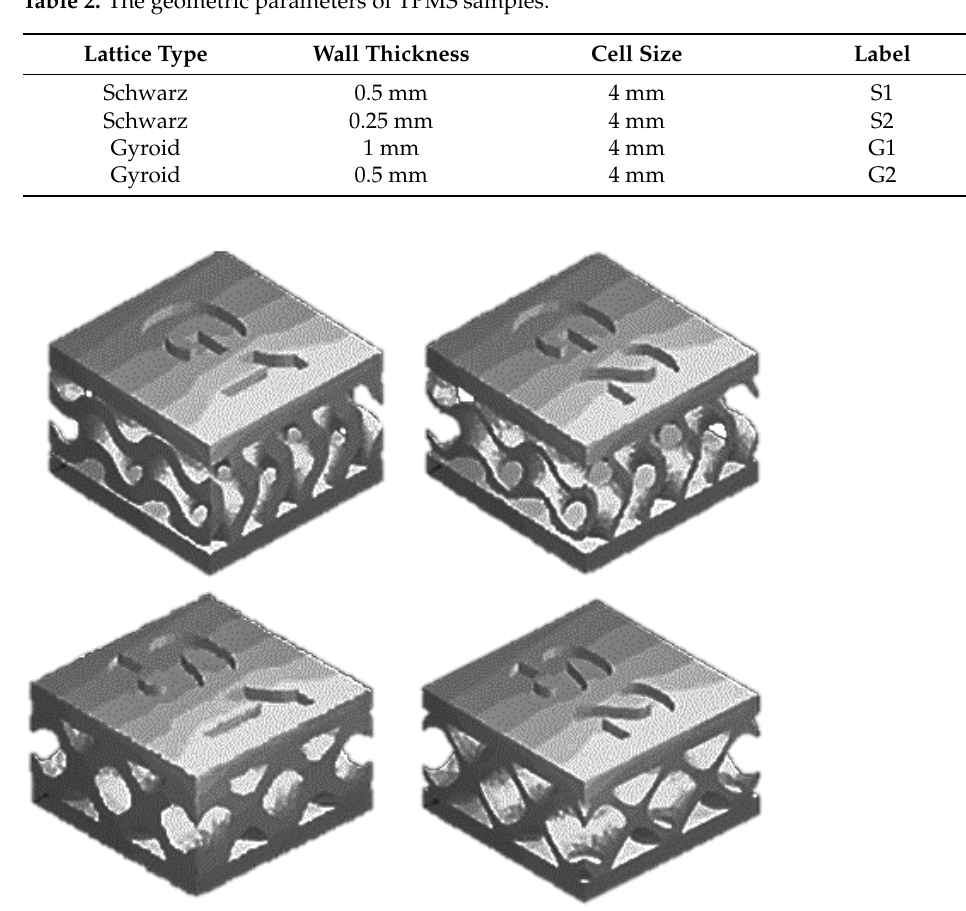
Figure 9. Computer models of TPMS structures of Gyroid- and Schwarz-type topology. Sintering and polarization of TPMS samples were achieved under the same conditions as those previously described for the cylindrical samples. Figure 10 shows images of samples at different stages of manufacturing.